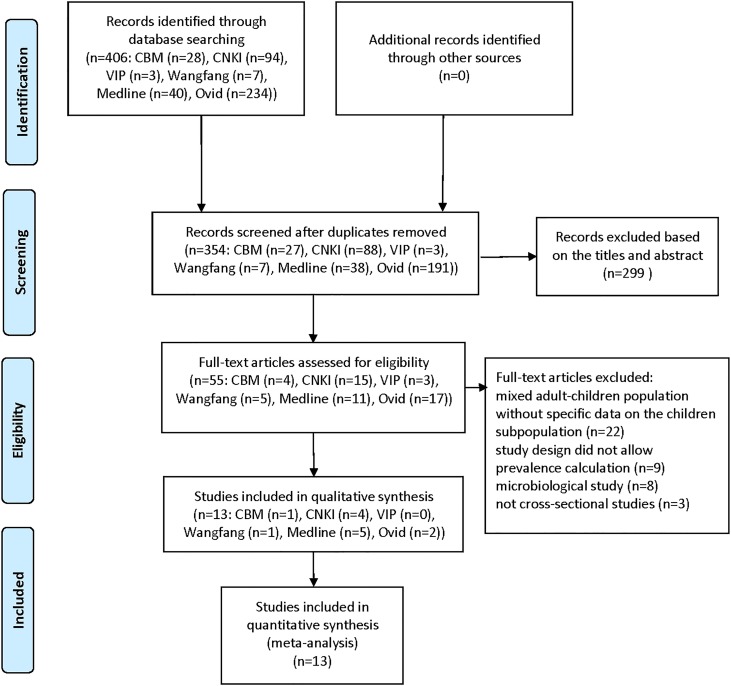
Flow diagram of the selection process of the included studies.